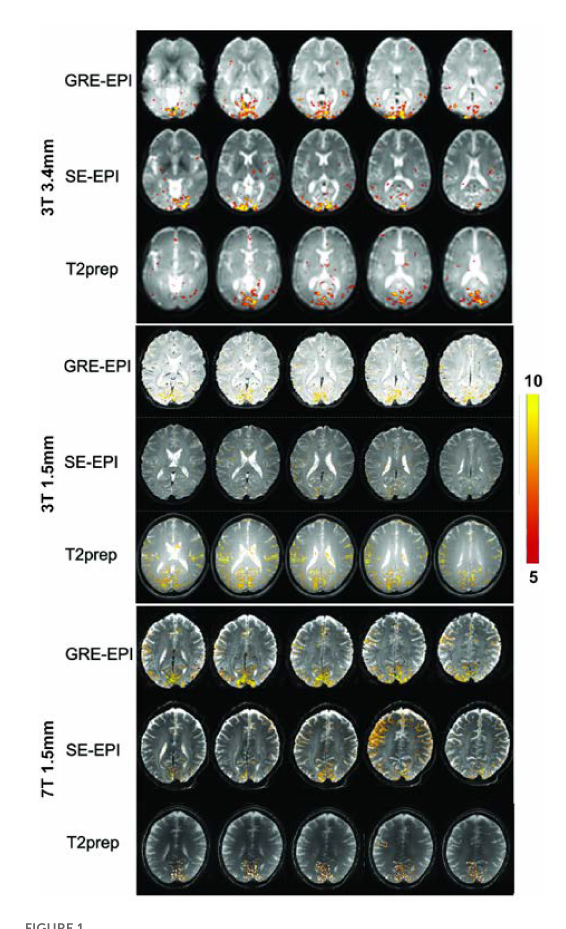
FIGURE1 Representative activation maps measured by gradient-echo (GRE) echo-planar-imaging (EPI), spin-echo (SE) EPI, and T2-prepared (T2prep) blood oxygenation level dependent (BOLD) functional MRI (fMRI) on 3T and 7T. The t-values of activated voxels were overlaid on respective fMRI images from each scan. The scale of t-values is indicated by the color bar on the right.